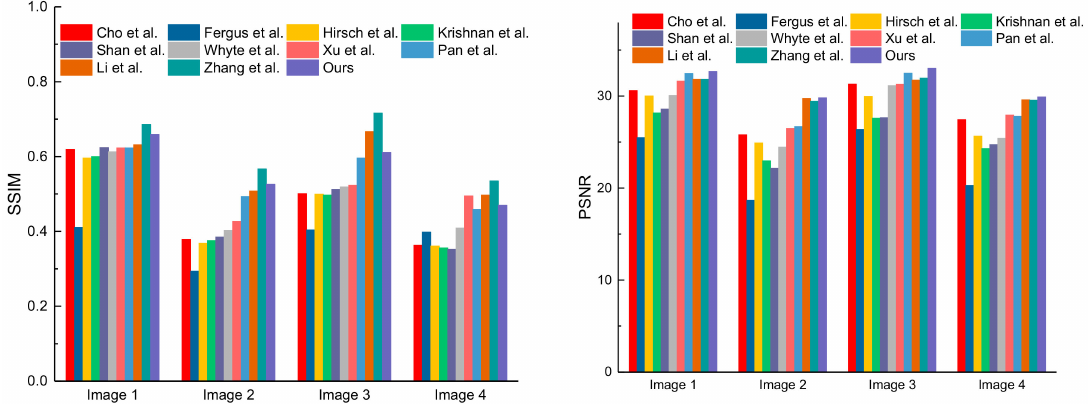
Figure 10. The quantitative results on the dataset of Köhler et al.